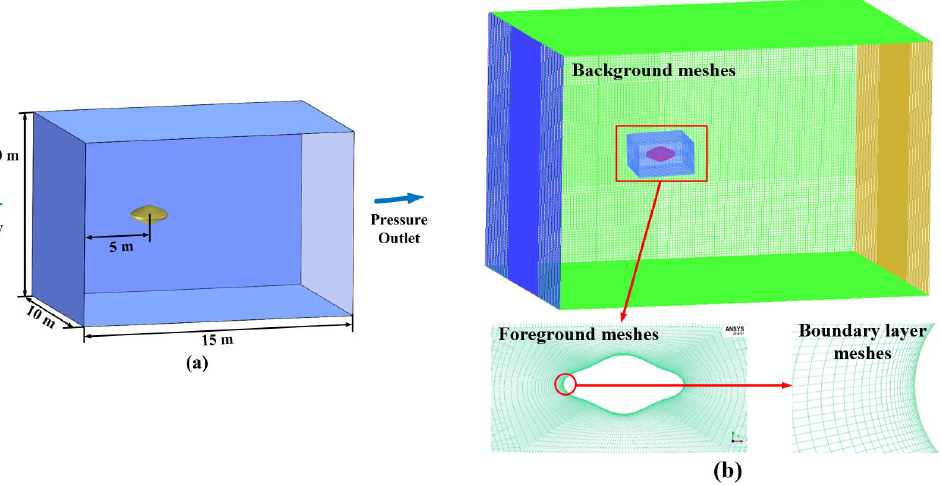
Figure 4. ( a ) Layout and boundary conditions of simulation domain; ( b ) hexahedral-structured meshes. By using the RNG 𝑘 − 𝜀 model and wall function, the boundary layer needs to be defined near the hull surface. Phillips et al. [16]proposed a method to calculate the thick- ness of the first layer of the boundary layer, ∆𝑦 = 𝐿𝑦 + √80𝑅𝑒 − diameter of the AUH), ∆𝑦 is the first layer thickness, 𝛿 is the boundary layer thickness, and 20 ≤ 𝑦 + ≤ 200 [25]. Consequently, 𝛿 = 5 mm and ∆𝑦 = 1 mm are adopted in the